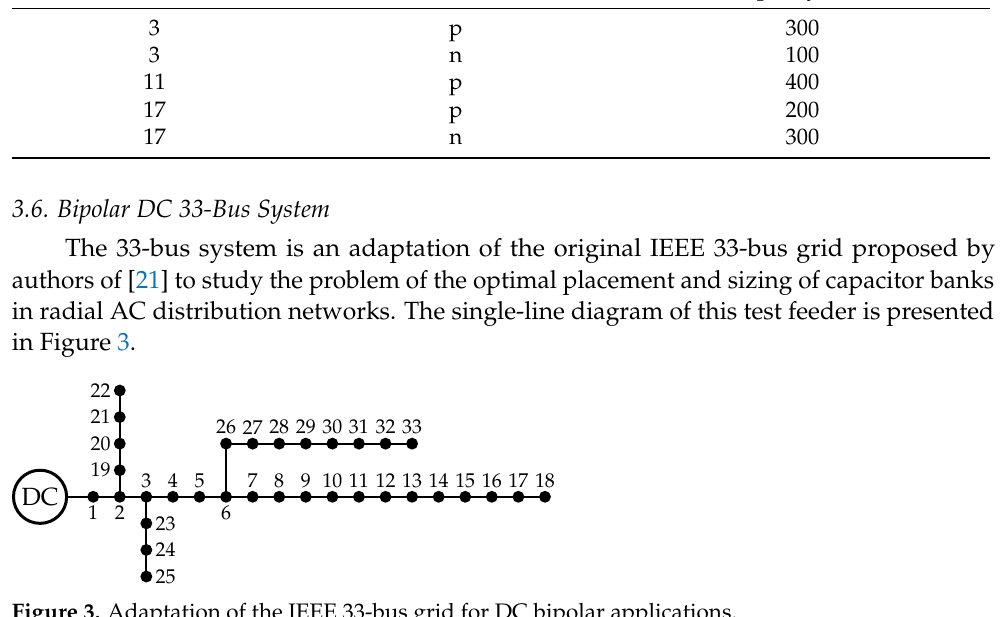
Figure 3. Adaptation of the IEEE 33-bus grid for DC bipolar applications.